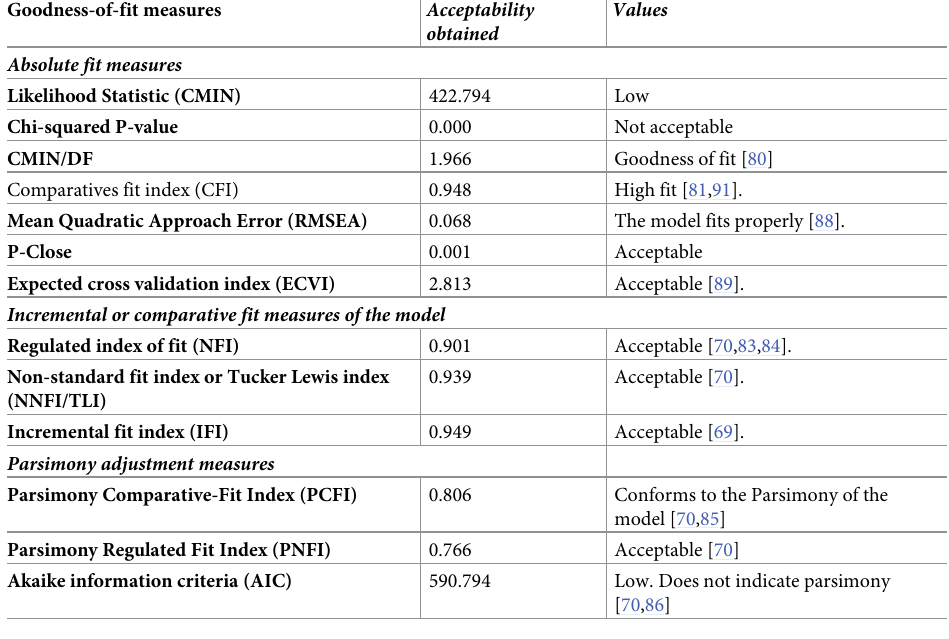
Table 10. Goodness-of-fit statistic of the CSRSMEs